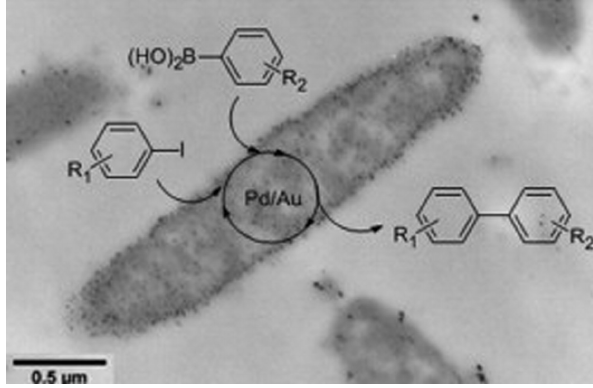
Figure 5 Bio-Pd/Au bimetallic nanoparticles for the Suzuki cross- coupling reaction. From [52] with